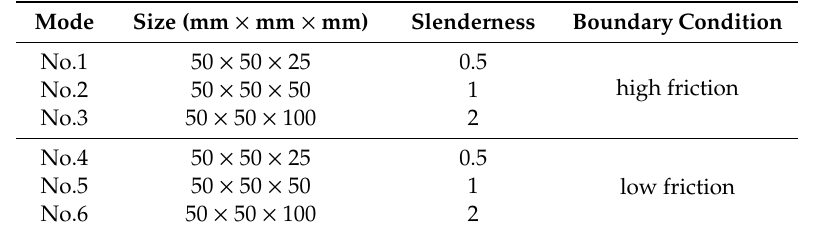
Table 4. Values of input parameters in the numerical analyses about slenderness and boundary conditions.